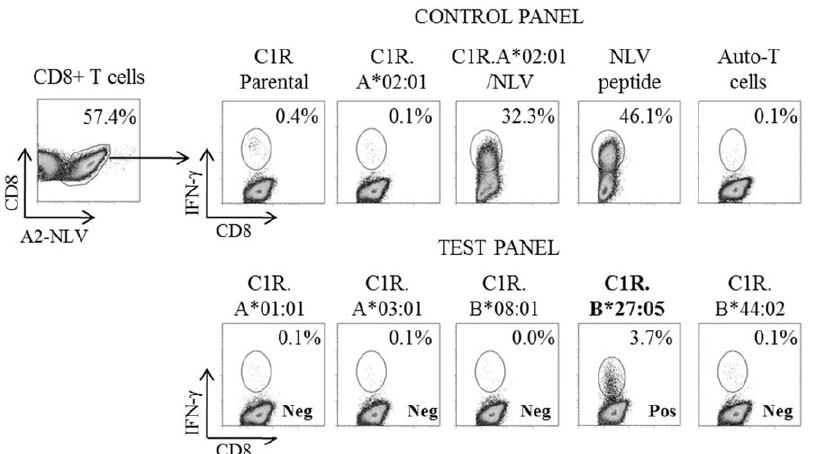
Figure 1. Cross-reactive NLV-specific CD8 + T cells via IFN- c production. NLV-specific CD8 + T cells from HC5 were expanded for 13 days before performing a 6 hour ICS assay against a panel of transfected cell lines and EBV-LCLs encompassing 6 HLA-A and 13 HLA-B antigens. Cross- reactivity was measured by the production of IFN- c in response to HLA antigenic stimulation after gating on tetramer + CD8 + T cells. Both the positive controls (C1R.A*02:01/NLV, NLV peptide) and negative controls (C1R Parental, C1R.A*02:01, T cells alone) responded as expected. No cross-reactivity was observed with the test panel, albeit C1R.B*27:05 which had a positive IFN- c response well above background levels. IFN- c responses towards 9009, 9026, T102, C1R.B*18:01, C1R.B*35:01, C1R.B*35:02, C1R.B*35:03, C1R.B*44:03, C1R.B*57:01, 721.221 Parental, 721.221.A*29:02, 721.221.A68 and 721.221.B53 were also negative (data not shown).